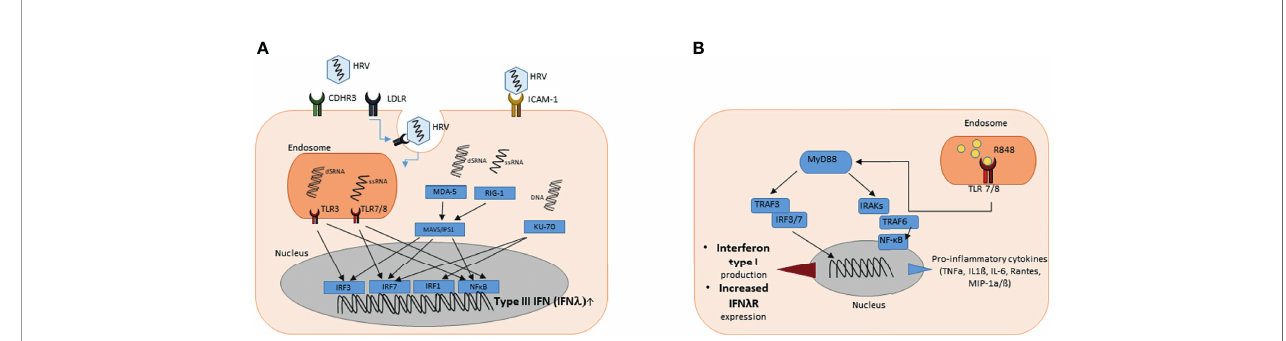
FIGURE 1 | (A) Graphical illustration of the induction of type III interferon gene expression upon rhinovirus infection. HRV enters the cell via ICAM-1 receptor, CDHR3 receptor or via clathrin-mediated LDLR endocytosis. Viral cytosolic and endosomal ssRNA and dsRNA can be detected by PRR and PRM such as RIG-1 or MDA-5 (cytosolic) or TLR3 and TLR7/8 (endosomal), respectively. PRR and PRM induce downstream signaling cascades leading to recruitment of IRFs and NF- k B that promote type III interferon gene expression in the nucleus. (B) Graphical illustration of the signaling pathway after TLR 7 and 8 activation by resiquimod (R848). TLR 7 and 8 are located in intracellular vesicles, where they bind ssRNA or substances that mimic their structure. After activation, the signal is transduced via Myeloid differentiation primary response 88 (MyD88). Important mediators are TNF receptor-associated factor (TRAF) 3 and 6 as well as different interleukin-1 receptor associated kinase family members (IRAKs). Interferon regulatory factors (IRF) 3 and 7 and nuclear factor ‘ kappa-light-chain-enhancer ’ of activated B-cells (NF- k B) are the key regulatory factors that in fl uence the gene expression in the nucleus. As a result the production of pro-in fl ammatory cytokines and type I interferons is